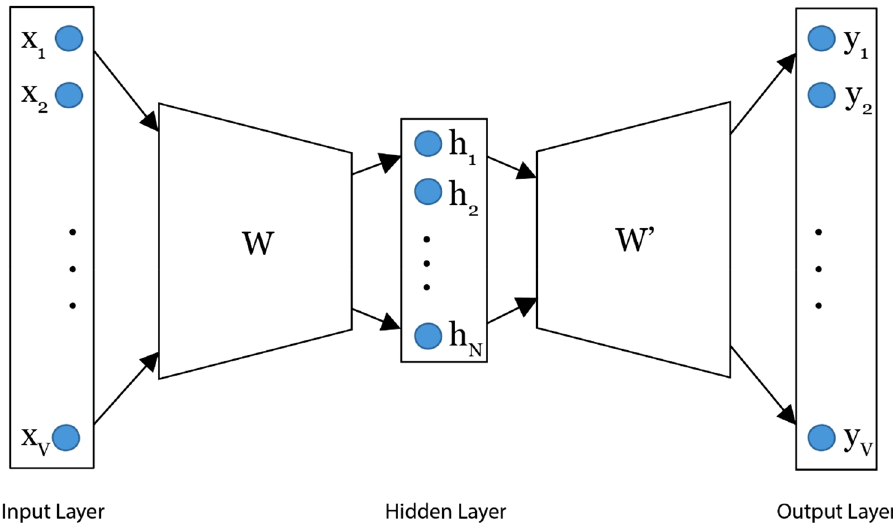
Figure 6. A continuous bag-of-words